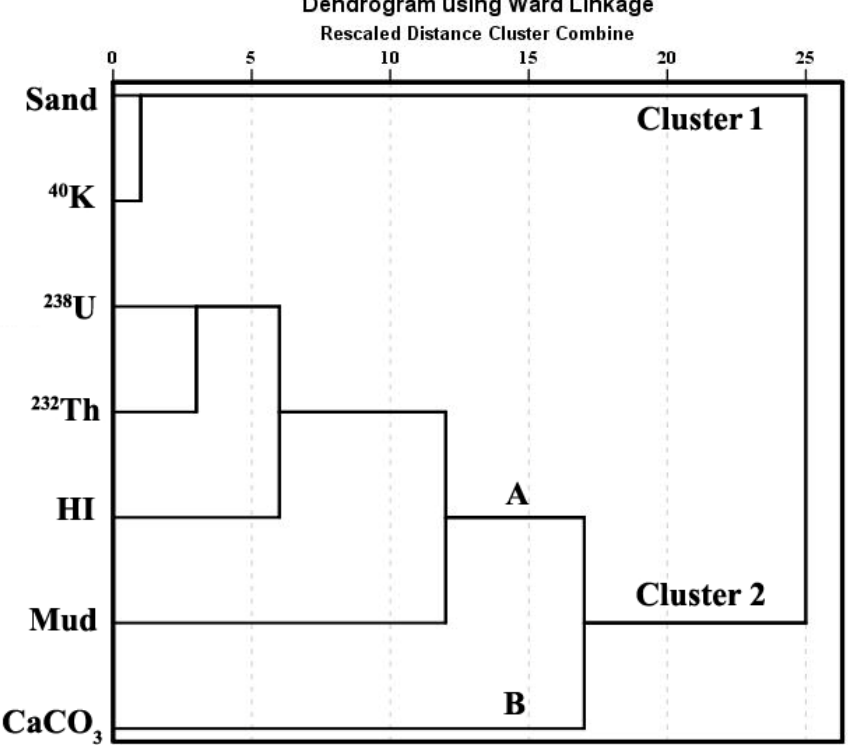
Figure 6. Q-Mode dendrogram of HCA analysis. Figure 7 present the 3D loading of PCA component; three components (PC1 (38.92), PC2 (30.04%), and PC3 (12.47%)) were extracted. The 3D plots of the extracted three components positively confirms the findings of PCC and HCA analyses.